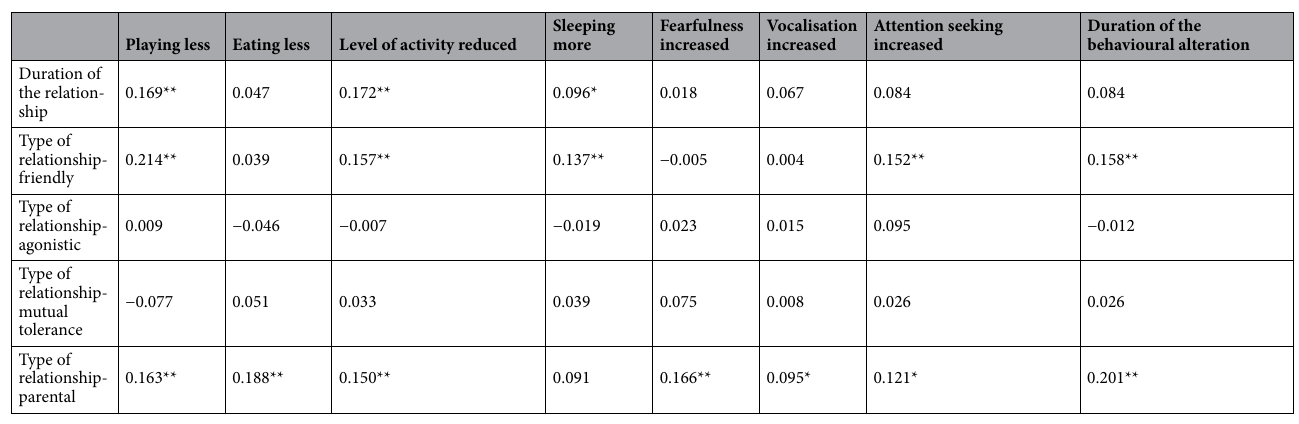
Table 1. Correlation between characteristics of the relationship between the two dogs and behavioural changes observed in the surviving dog after the death of the other dog. * p < 0.05; ** p < 0.01; *** p < 0.001.